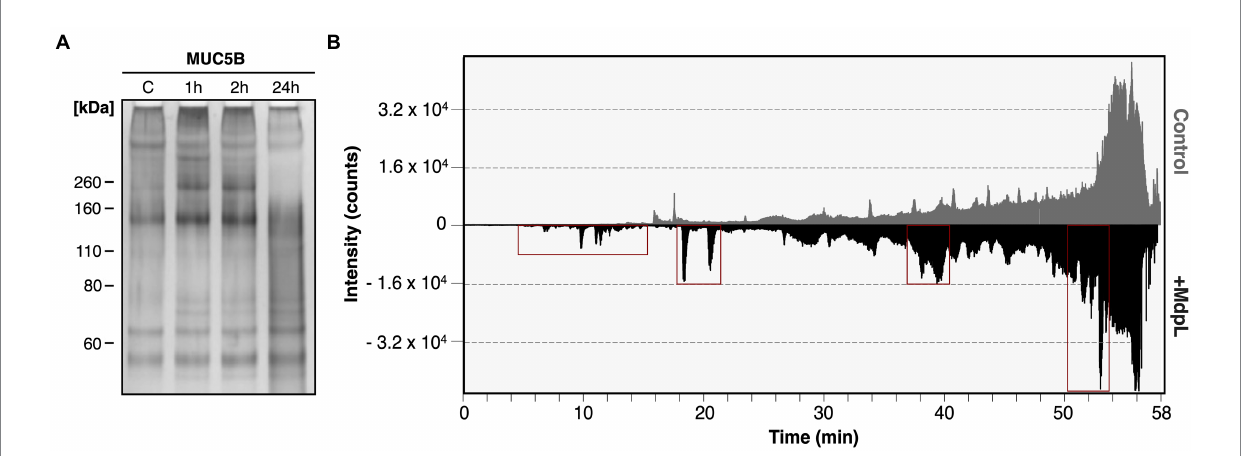
FIGURE 4 Degradation of MUC5B by MdpL. (A) Reduced MUC5B subjected to SDS-PAGE followed by silver staining, displaying low molecular weight fragments after 1, 2, and 24 h incubation with MdpL. (B) A mirrored nano-UHPLC chromatogram of digested MUC5B displays the total ion chromatogram (TIC) of Lys-C-digested MUC5B control (upper) and MdpL/LysC-digested MUC5B (lower). Distinct peak increases between the upper and lower panel have been depicted with red